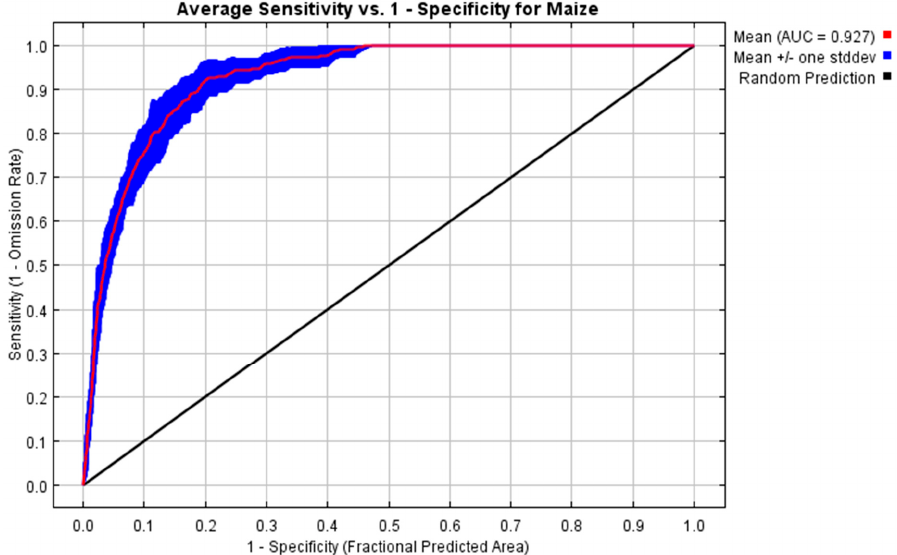
Figure 5. The receiver operating characteristic (ROC) curve. The values shown are the average of the replicate